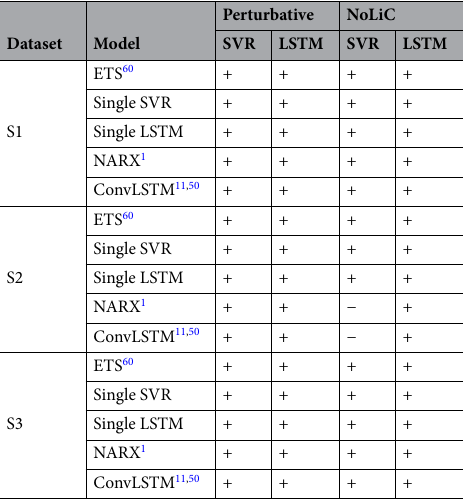
Table 7. Results of the comparison of the hybrid systems using SVR and LSTM with single and literature models using Diebold–Mariano hypothesis test.